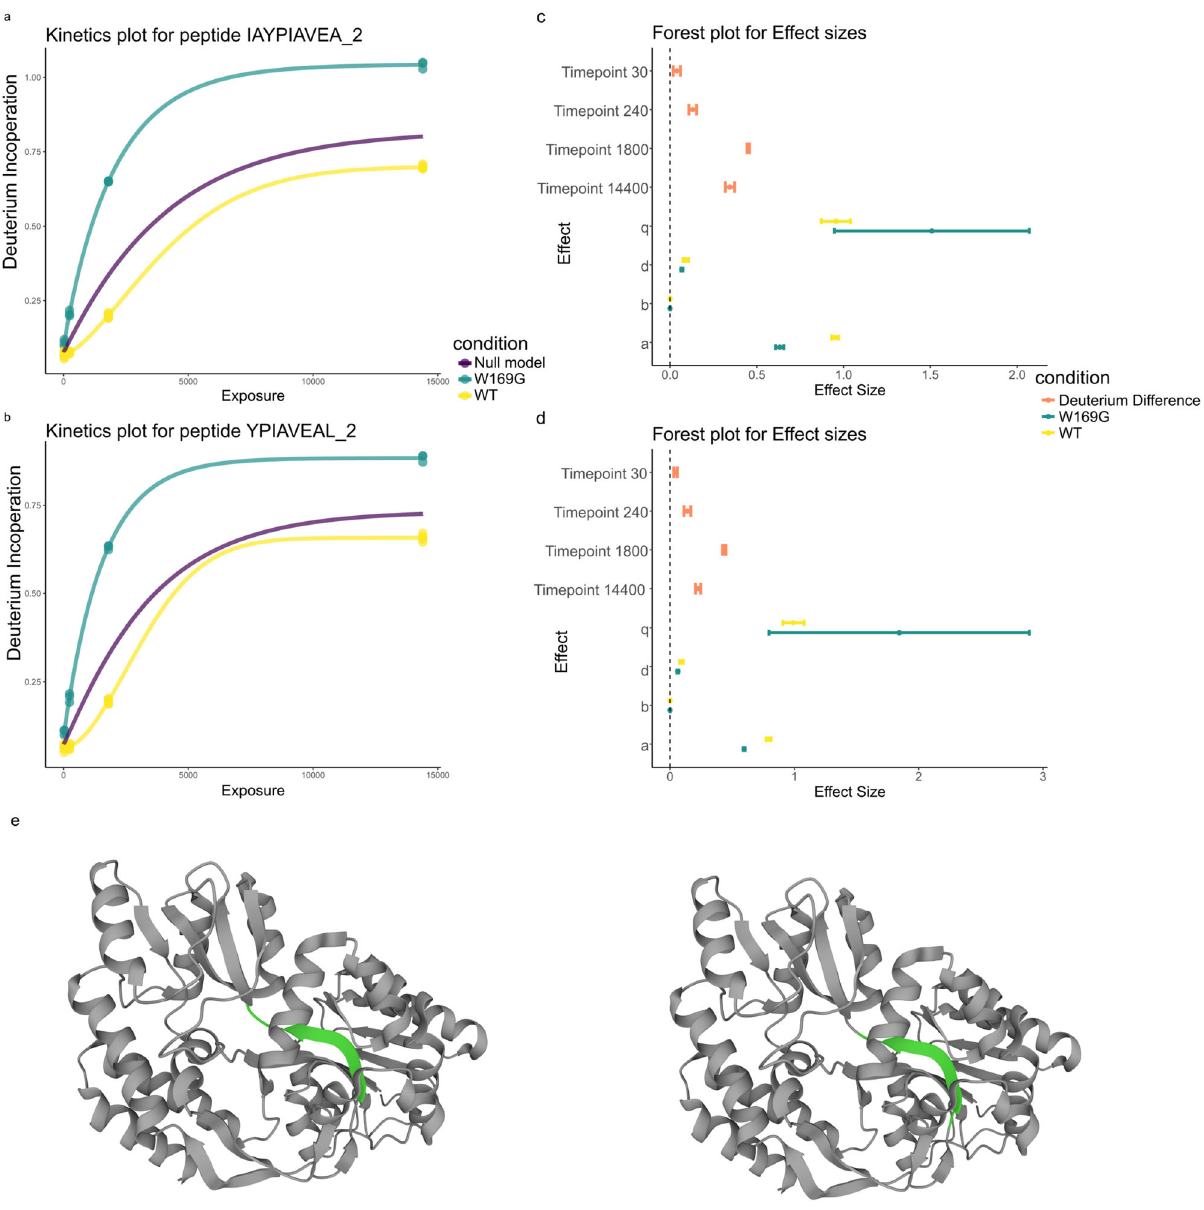
Fig. 3 Functional models are interpretable. a Deuterium kinetics for peptide IAYPIAVEA [119-138] in charge state two. Proportion of deuterium incorporated is plotted against solvent exposure time in seconds. Conditions are coloured with the null model in purple. The number after the underscore indicates the charge state. ( b ) same as for ( a ) but for peptide YPIAVEAL [131 – 139] in charge state one. c Forest plot for effect sizes corresponding to peptide in IAYPIAVEA [129 – 138]. d Forest plot for effect sizes, the strength of relationship between variables (see methods), corresponding to peptide in YPIAVEAL [131 – 139]. c , d The pointer refers to the mean estimate with tails corresponding to the 95% con fi dence interval. e MBP (PDB: 1OMP) with peptides highlighted in green YPIAVEAL [131 – 139] (left) IAYPIAVEA [129 – 138]